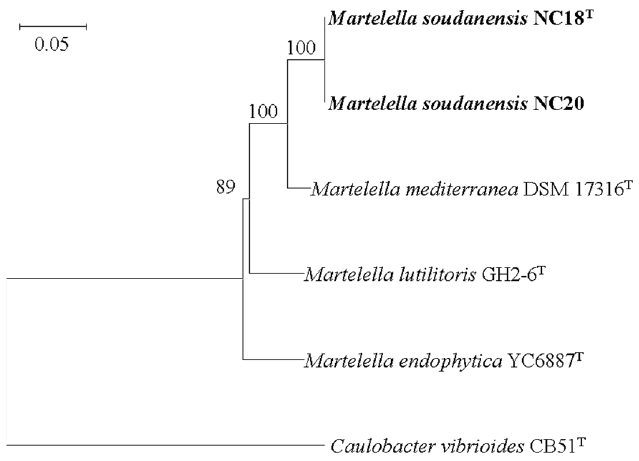
Figure 2. Multilocus sequence analysis (MLSA) tree based on 31 universally conserved protein sequences of strains NC18 T and NC20 with other related taxa. Evolutionary distances computed using JTT matrix-based method. Evolutionary history inferred using the neighbor-joining method. Bootstrap values (tested as 1000 replications) above 50% are shown next to branches. Sequence of Caulobacter vibrioides CB51 T used as outgroup. Bar, 0.05 nucleotide substitution per position. Accession numbers for each sequence are shown in Supplementary Table S1.